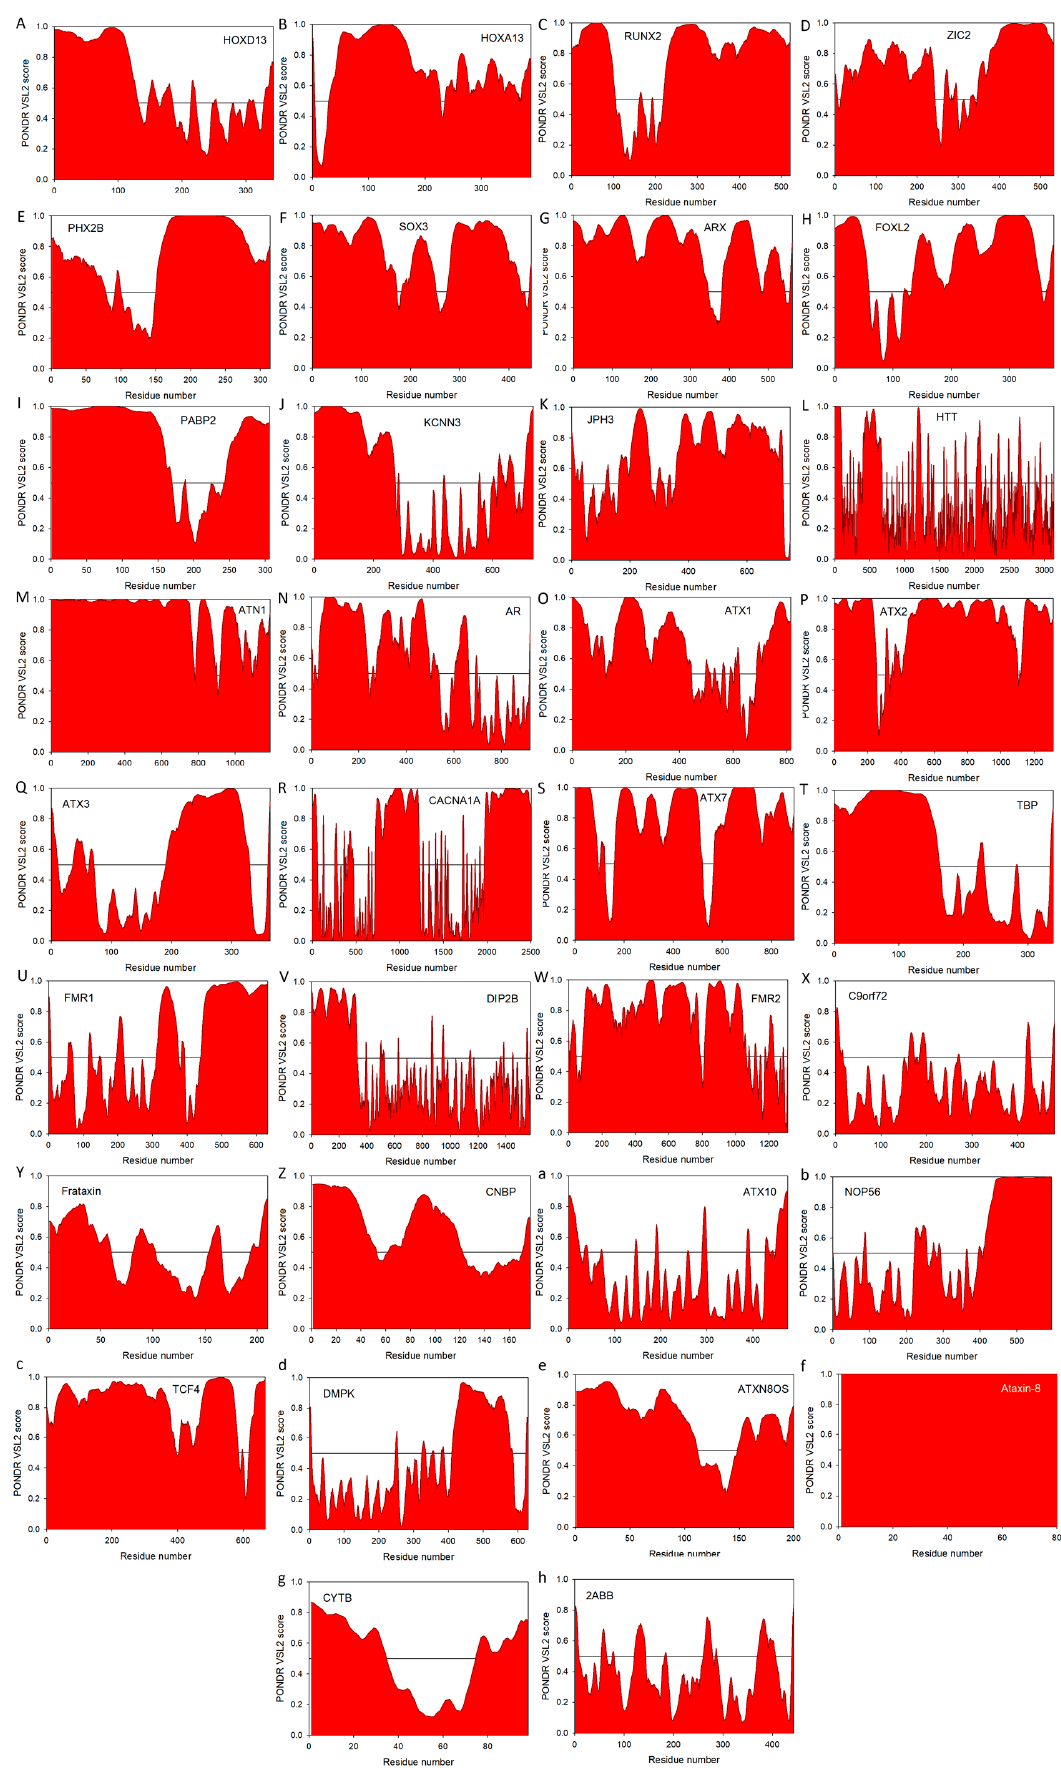
Figure 2. Evaluation of intrinsic disorder propensities of 33 proteins associated with the proteins caused by the nucleotide expansions. Intrinsic disorder predisposition was evaluated by PONDR